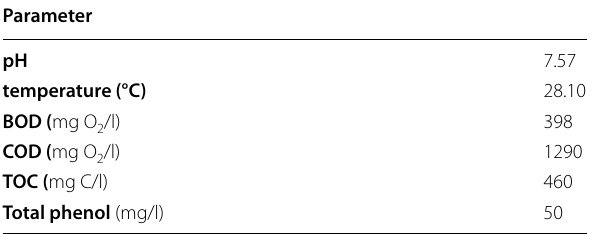
Table 1 Temperature, pH, BOD, COD, TOC, and total phenol in wastewater